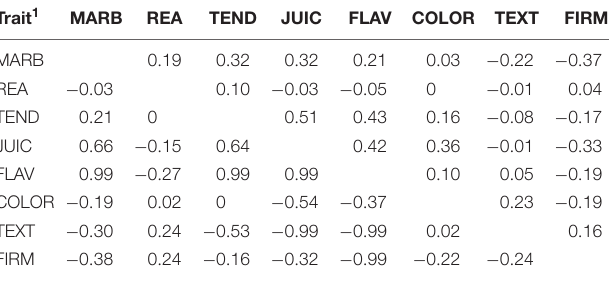
TABLE 3 | Two-trait AIREML estimates of phenotypic (above diagonal) and direct additive genetic (below diagonal) correlations between carcass quality, sensory meat quality, and visual meat quality traits in a multibreed Angus–Brahman